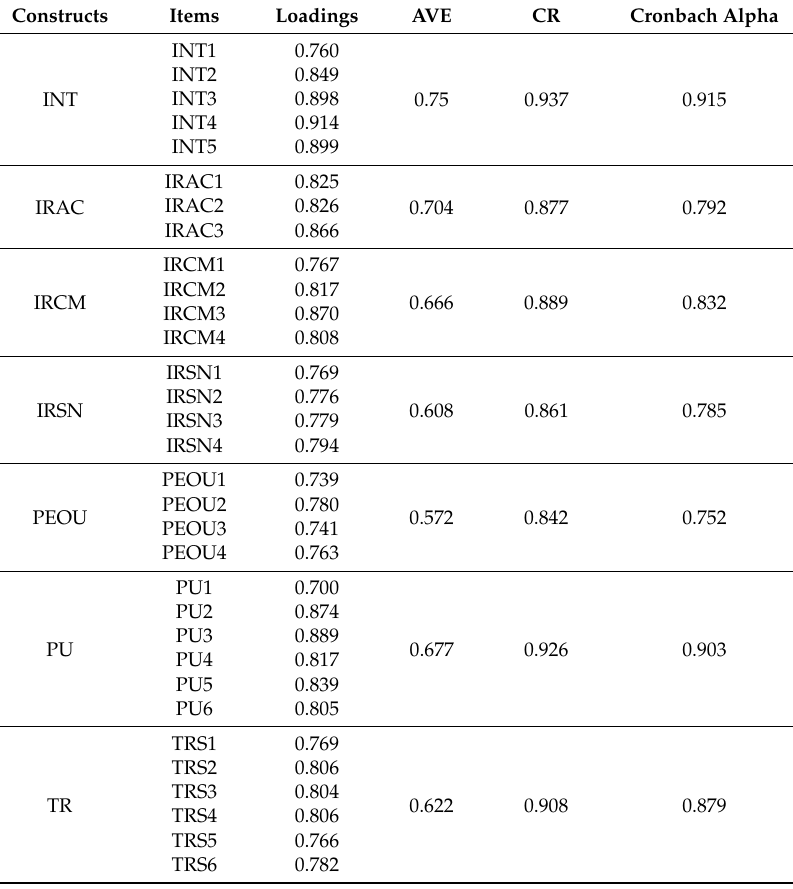
Table 2. Reflective Measurement Model